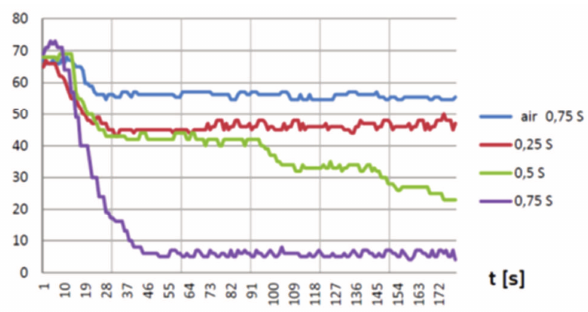
Fig. 6. Changes in concentrations of sulfur oxide with sorbent supply, where: 0.025S; 0.5S; 0.75S – degree of opening of the control valve; air 0.75S – air supply to the reactor at an opening of 0.75 valve stroke